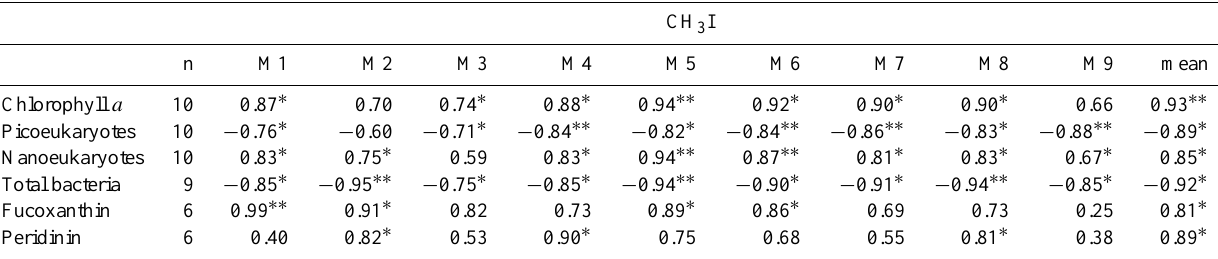
Table 3. Correlation coefficients ( R ) for CH 3 I (pmolL − 1 ) and selected biological parameters during PI ( t 4 – t 12 ). Asterisks indicate associated probability: ∗ p < 0.05, ∗∗ p <